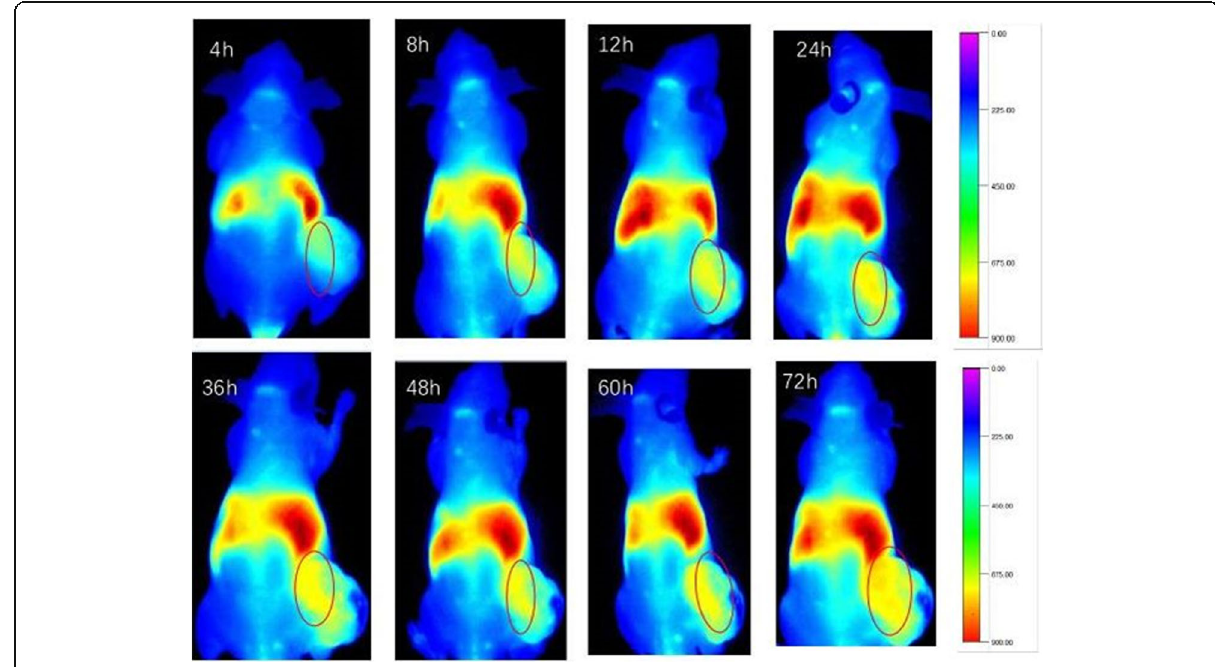
Fig. 3 Whole body image of CSO-SA/DiR at different times after i.v. injection